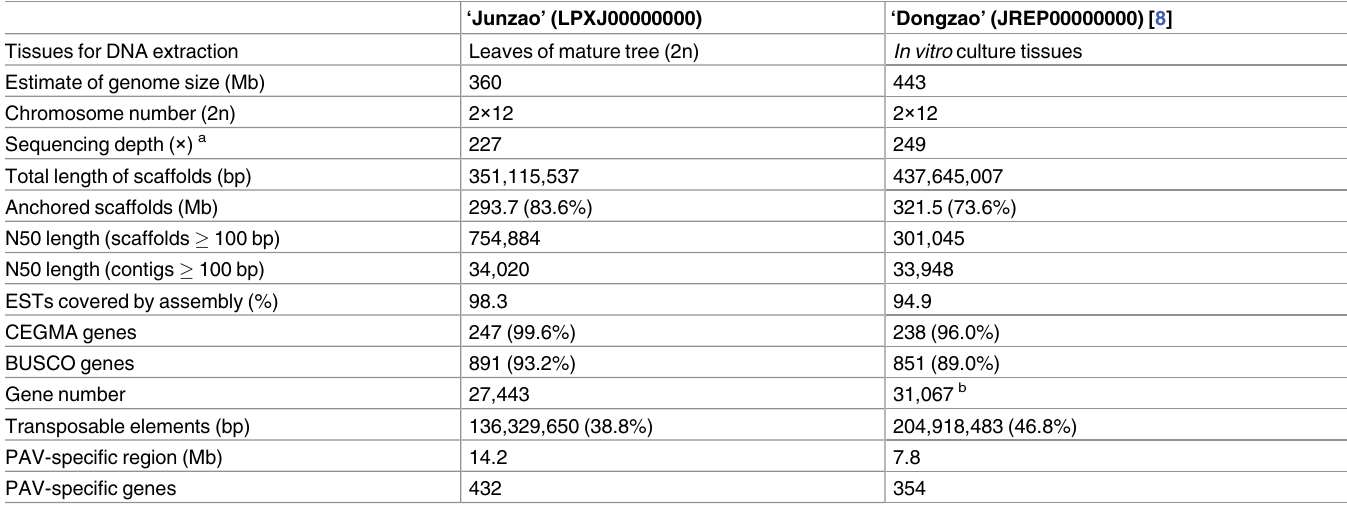
Table 1. Comparison of assembled genomes between ‘Junzao’ and ‘Dongzao’ ‘Junzao’ (LPXJ00000000) ‘Dongzao’ (JREP00000000) [8] Tissues for DNA extraction Leaves of mature tree (2n) In vitro culture